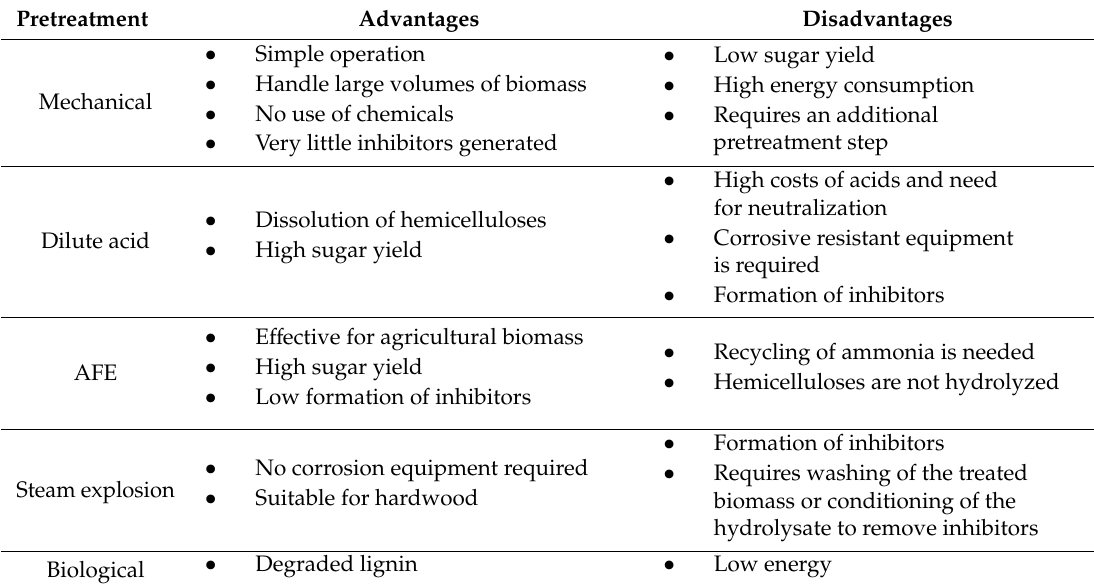
Table 1. Advantages and disadvantages of di ff erent pretreatment methods of lignocellulosic biomass (adapted from